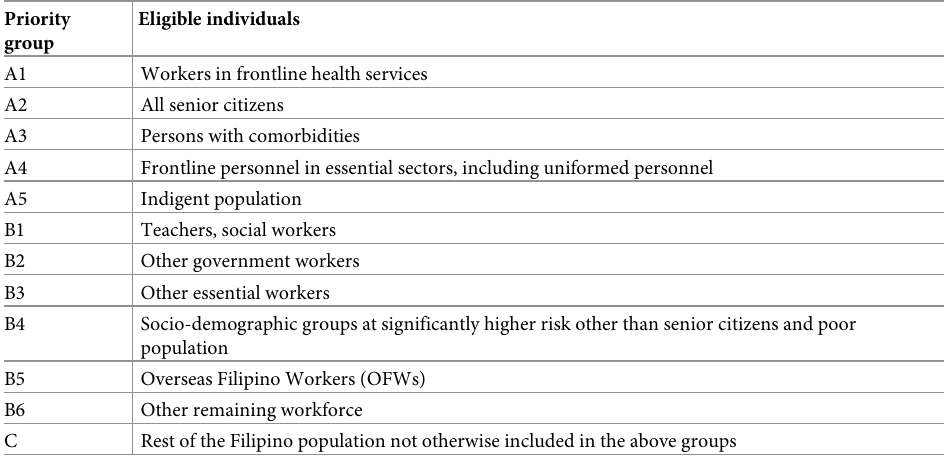
Table 1. Vaccine prioritisation framework